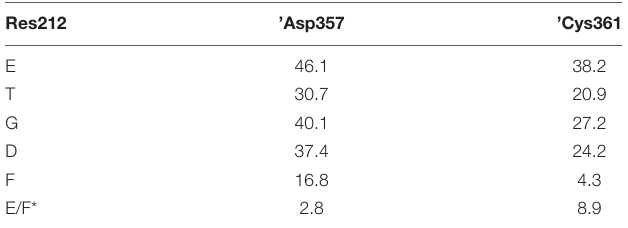
TABLE 2 | Proportion (%) of residue ’Asp357 and ’Cys361 with χ 1 values of ∼ -60 ◦ in MD simulations with different residues at position 212. Res212 ’Asp357